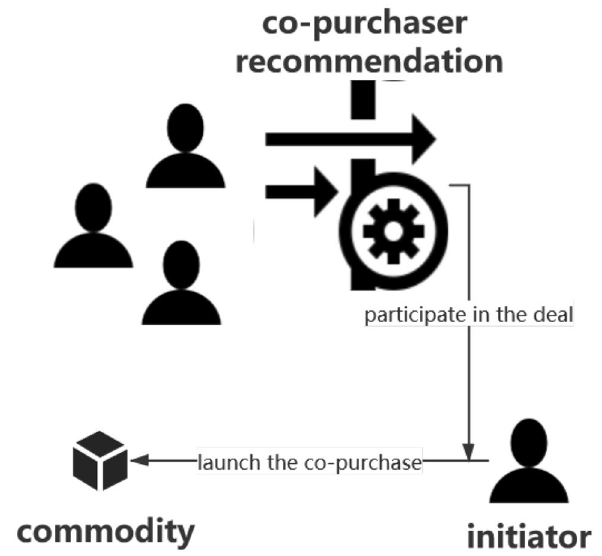
Fig. 2 Co-purchaser